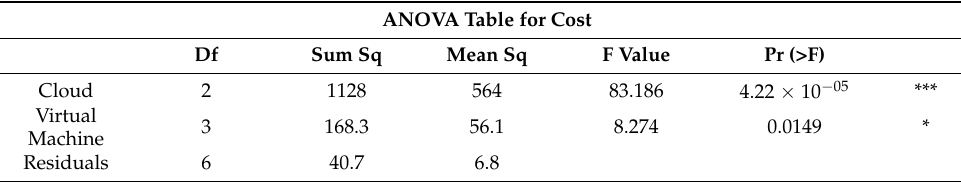
Table 5. ANOVA Table for Cost on clouds for different virtual machines.